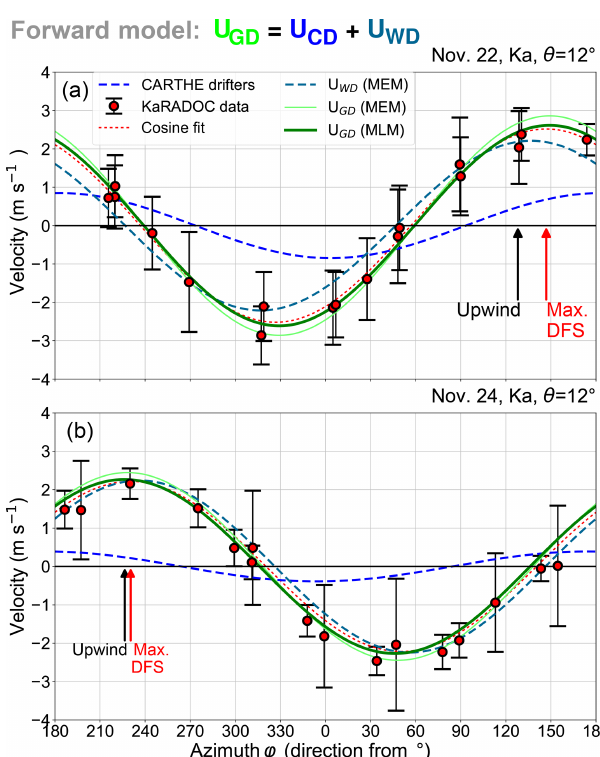
Figure 14. TSCV retrieval U CD (in blue) obtained by subtracting the U WD from the MLM-processed Trèfle buoy data (in midnight blue) from the U GD vector determined from the KaRADOC mea- surements (in red) compared to field measurements by HF radar, CARTHE and SVP drifters (shades of gray) on (a) 22 and (b) 24